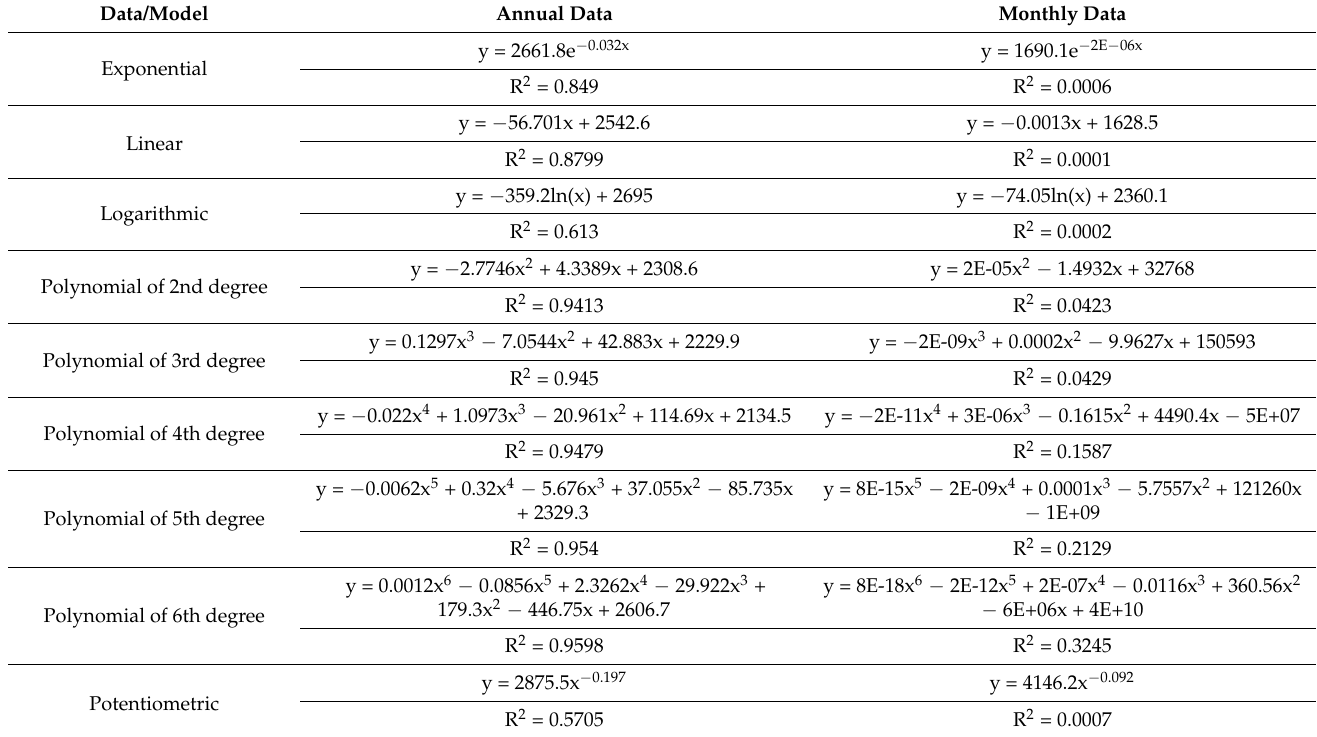
Table A9. Trend models for the Subcarpathia